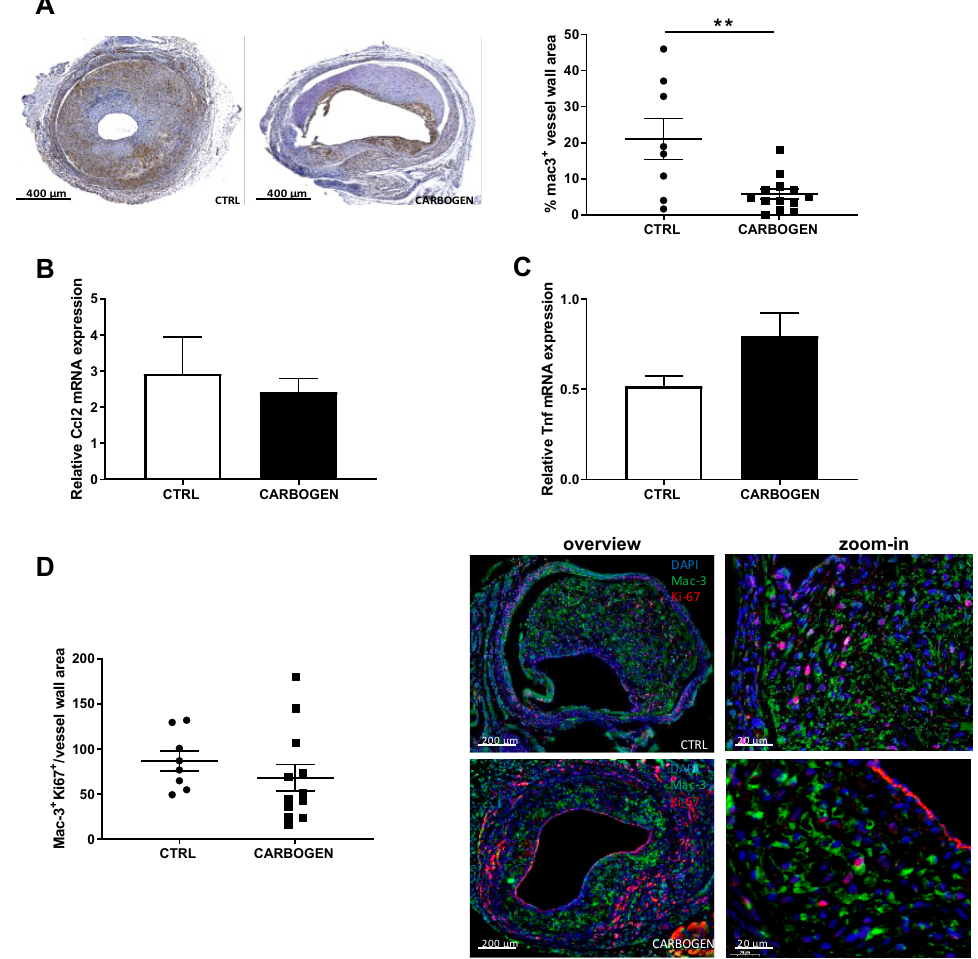
Figure7. Chroniccarbogentreatmentreducesmacrophagesinfiltrationintheplaque. ( A )Representative pictures of ApoE3* Leiden mice vein grafts from control ( n = 8) and chronic carbogen treated ( n = 13) groups stained for Mac-3. In the right panel quantitative measurements of the percentage of vessel wall area positive for Mac-3. Data are presented as mean ± SEM. ** p < 0.01; by two-sided Student’s t test. Total wall gene expression of ( B ) Ccl2 and ( C ) Tnf relative to Hprt. ( D ) Quantification of the number of cells positive for Mac-3 and Ki67 in the vessel wall area of control ( n = 8) and carbogen treated group ( n = 13) and representative pictures of the staining with DAPI presented in blue, Mac-3 in green and Ki67 in red. Data are presented as mean ± SEM. ** p < 0.01 by 2-sided Student t